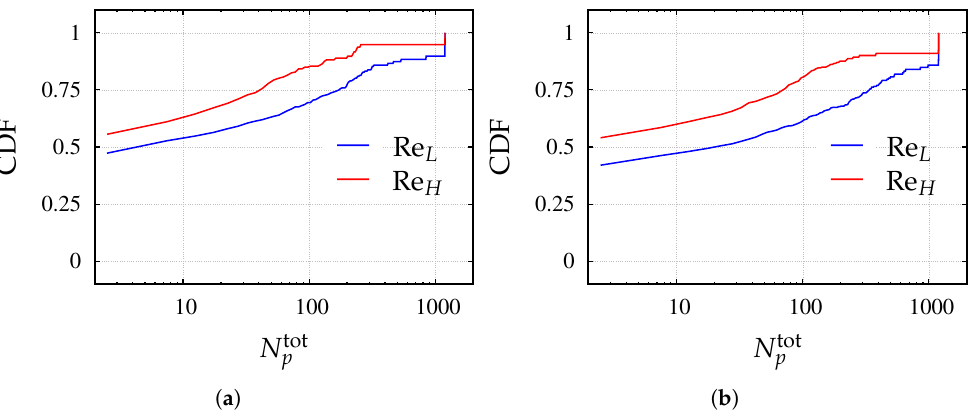
Figure 19. Cumulative mass-weighted agglomerate size distribution Q 3 at the outlet of the pipe. ( a ) 90 ◦ pipe bend. ( b ) 45 ◦ pipe